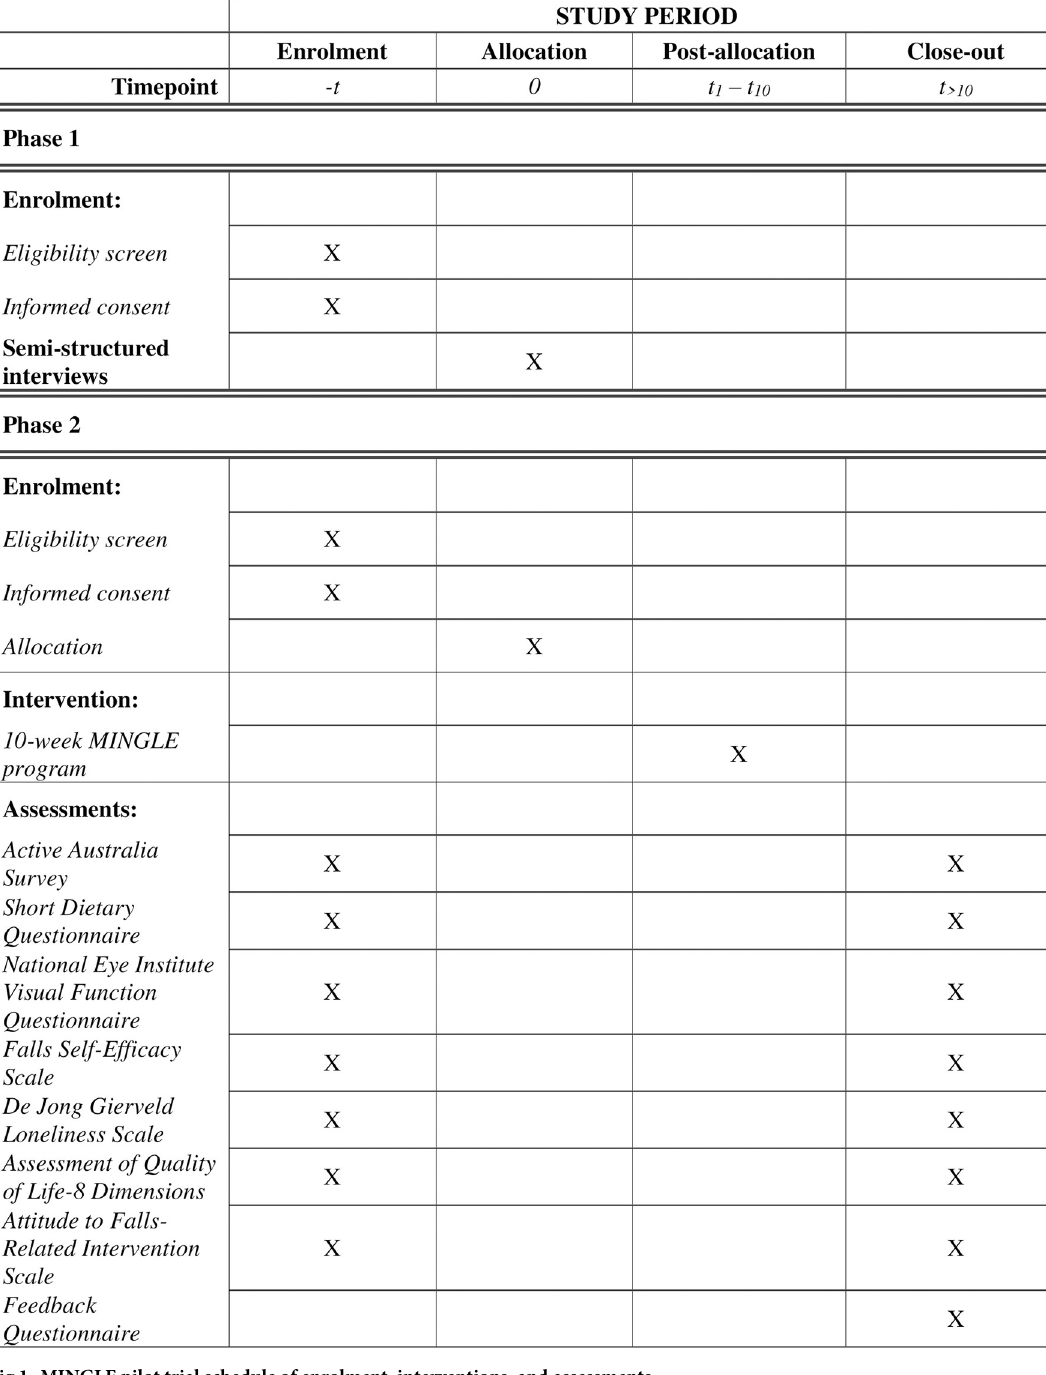
PLOS ONE | https://doi.org/10.1371/journal.pone.0267581 May 12,